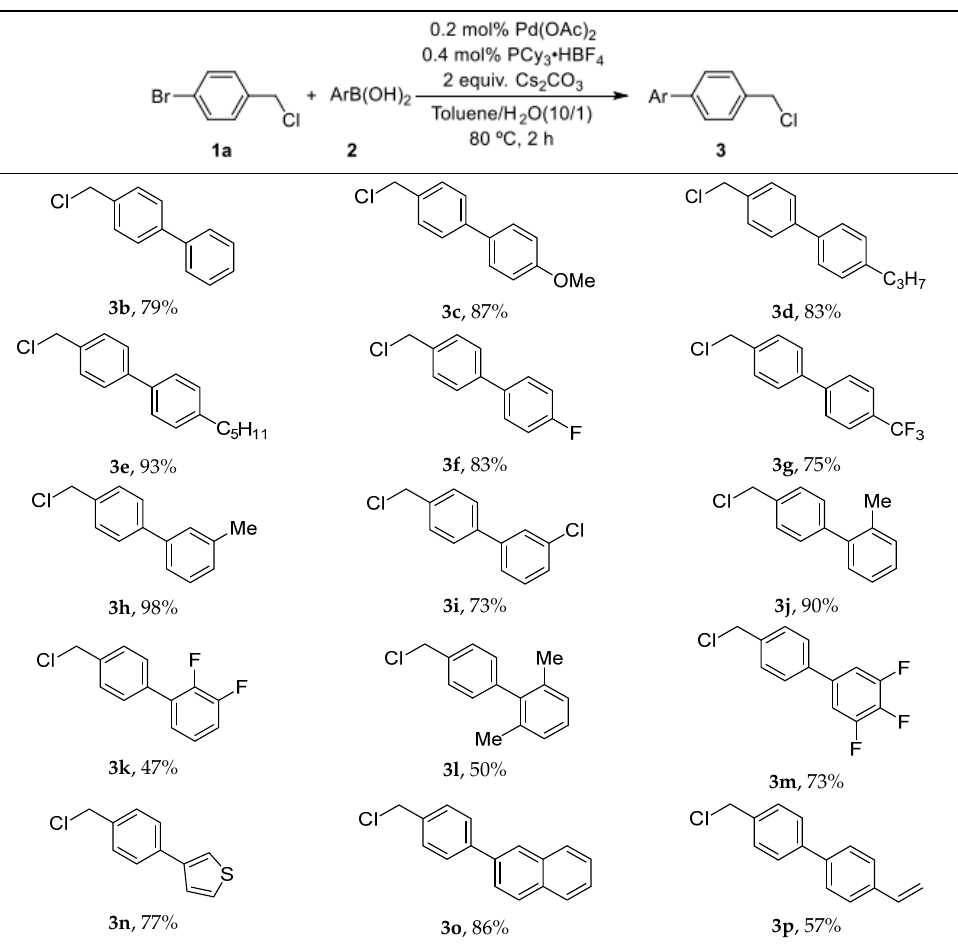
Table 2. Selective coupling reaction of 1-bromo-4-(chloromethyl)benzene with arylboronic acid a .